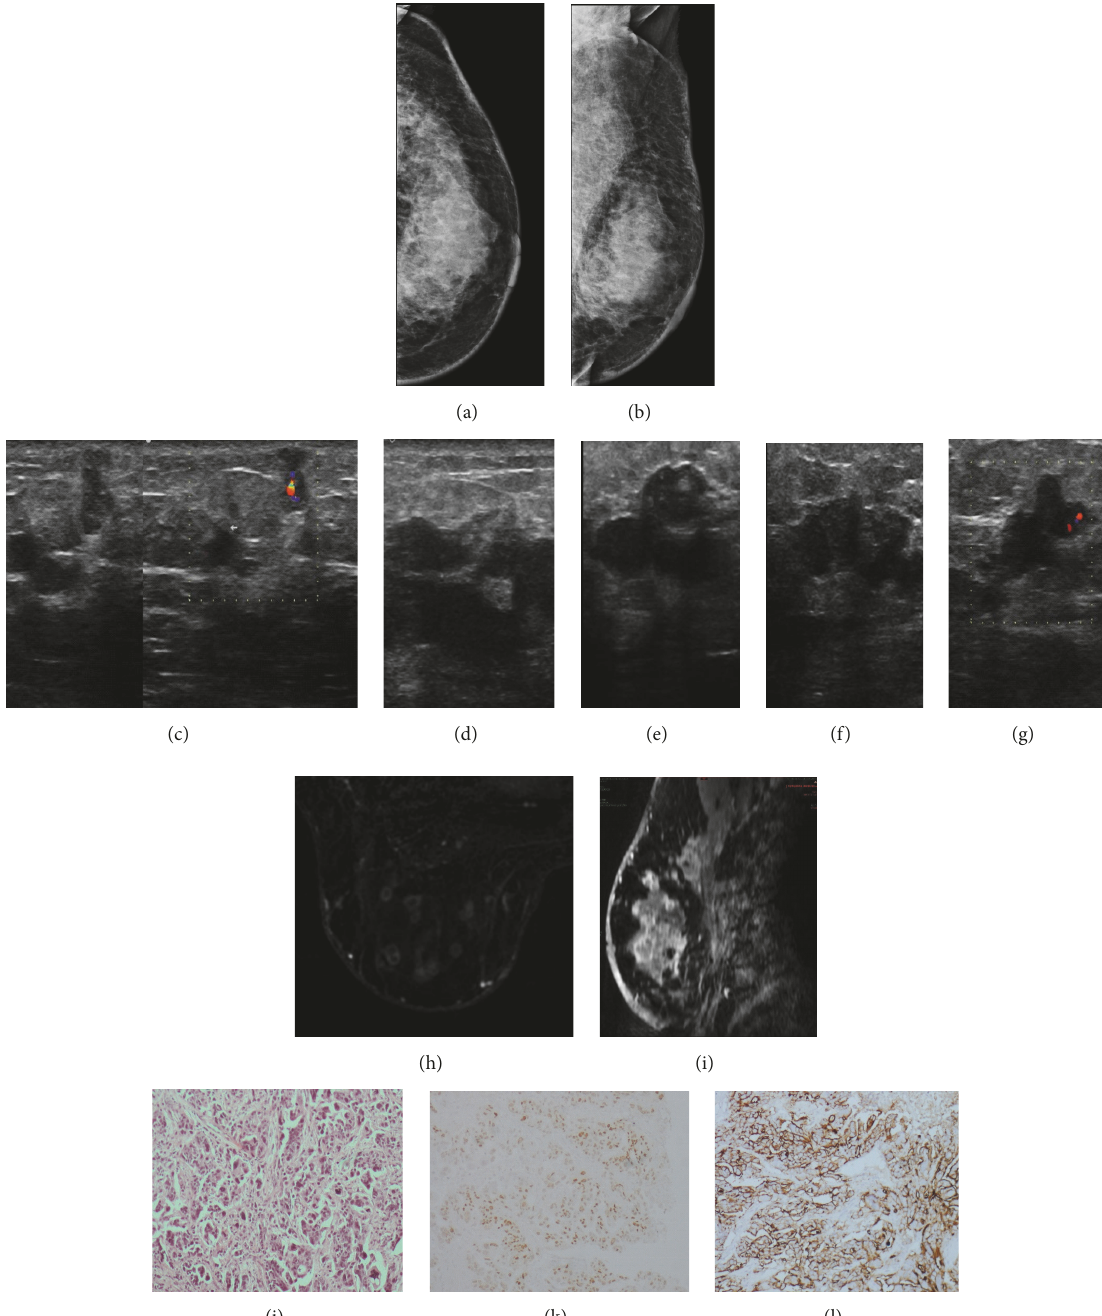
Figure 2: Case2. A 60-year-old woman diagnosed with papillary serous ovarian carcinoma. A palpable mass in the left breast was noticed by the patient 2 years after initial diagnosis. Mammogram revealed dermal thickening and diffusely increased breast density ( a–b ). A distortion was evident in the breast tail as well, indicating skin retraction ( b ). Grayscale and Doppler ultrasound showed bilateral hypoechoic irregular masses with angular margins. A nonparallel orientation and central vascularity were observed in some masses. Multifocal and diffuse distribution of the lesions was noted on ultrasound ( c–g ). Similarly, subtracted images from magnetic resonance demonstrated multiple irregular masses with circumscribed margins and rim enhancement ( h ). Conglomerate lesions infiltrating the major pectoralis muscle were also exposed ( i ). HE staining and immunohistochemistry analysis of the metastases. HE staining revealed the malignant cells in the breast tumor ( j ), and the immunohistochemistry analysis indicated that the cells were positive for PAX8 ( k ) and CA125 ( l